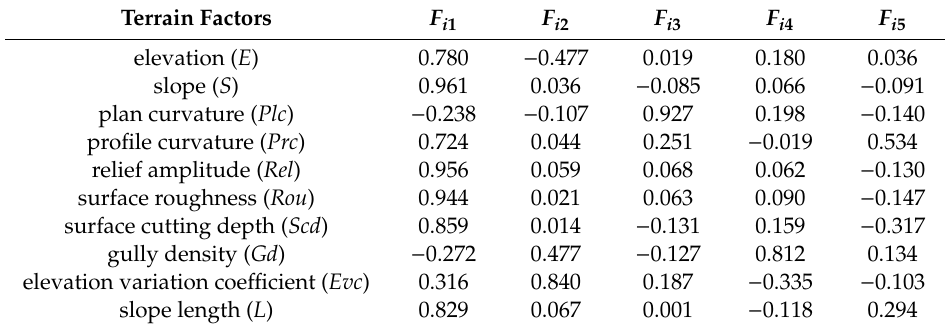
Table 2. Component matrix of the ten terrain